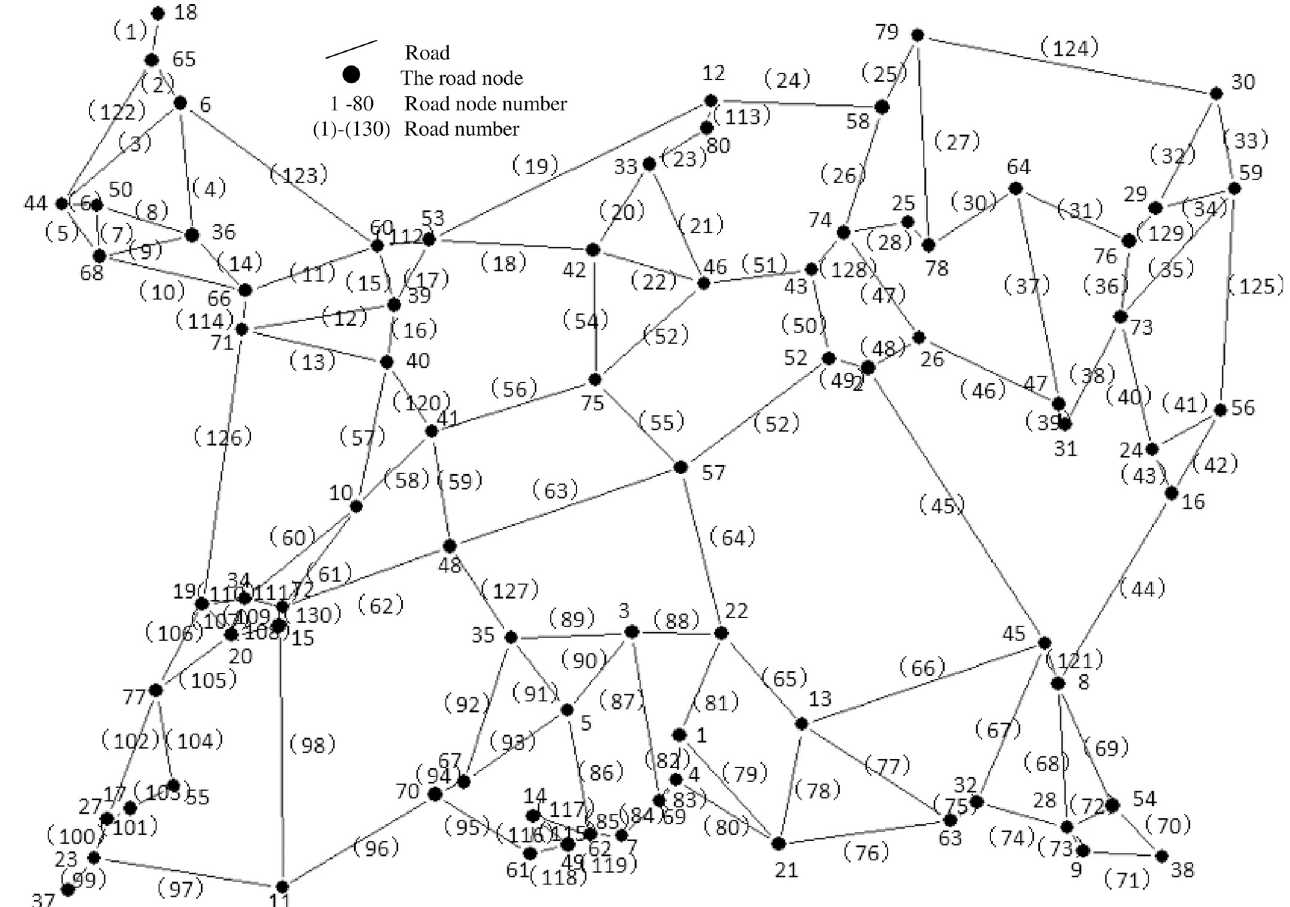
Fig 4. Topology diagram of road network.